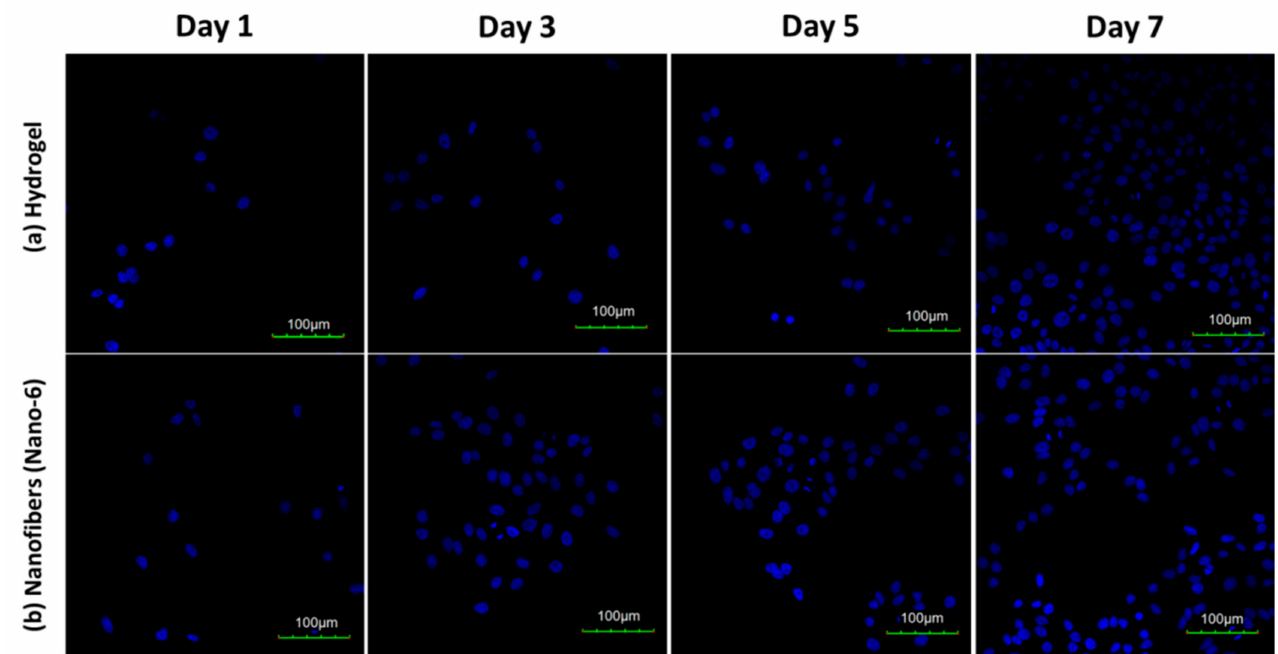
Figure 12. CLSM images of LoVo cells on ( a ) hydrogel and ( b ) hydrogel nanofibers (Nano-6 sample). The fluorescence is blue labeled by DAPI (a marker for the cell nucleus), and the scale bars are 100 µ m. All samples were cultured for one, three, five and seven